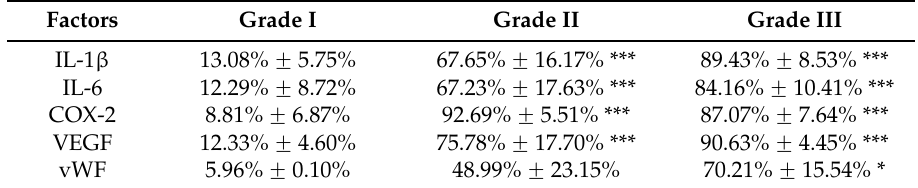
Table 2. Comparison of the inflammatory and angiogenic factors change among three